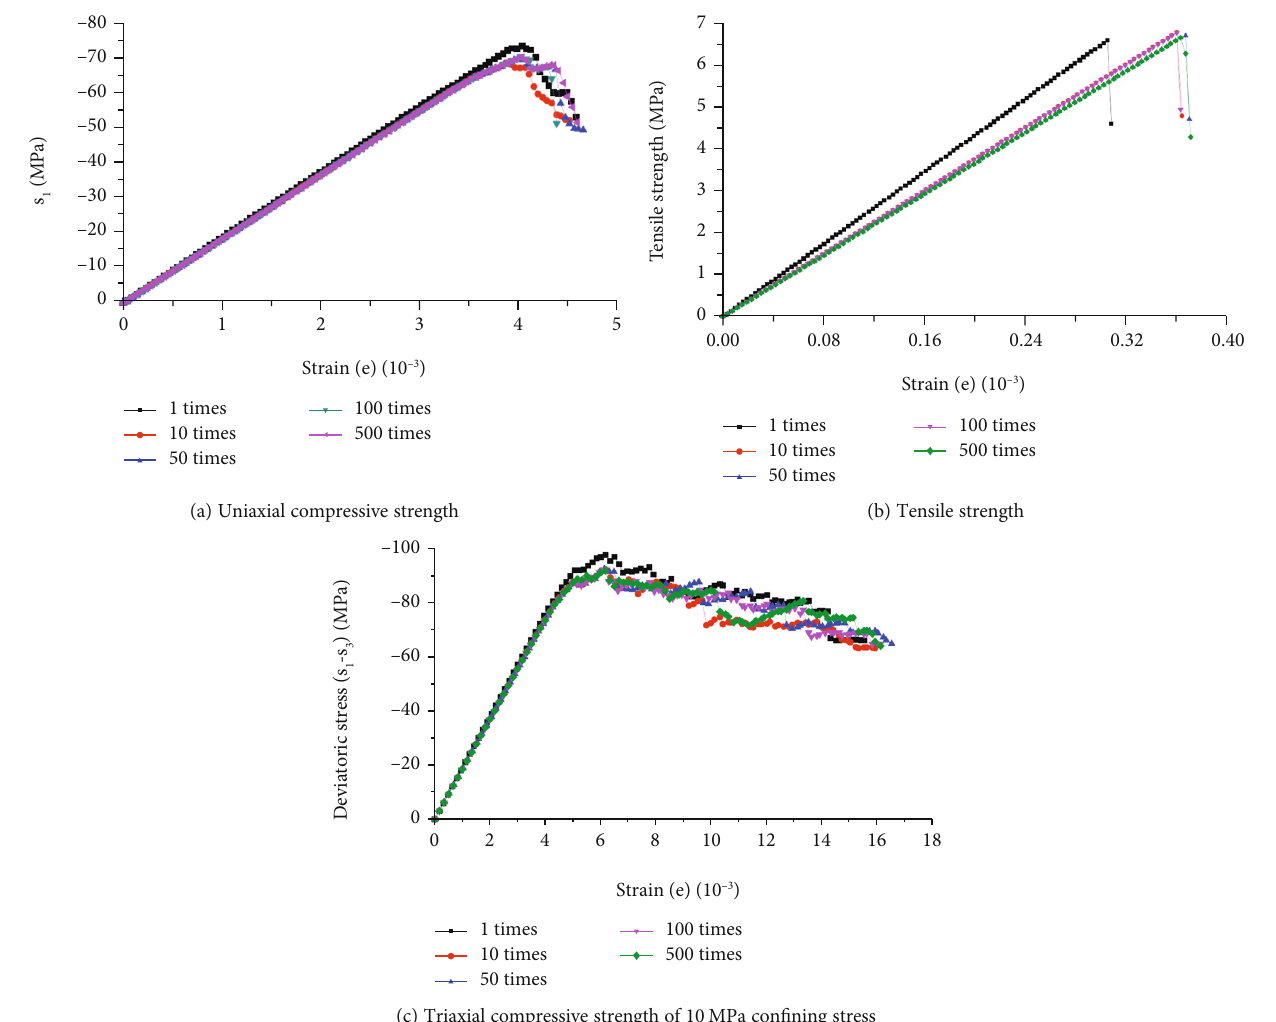
Figure 5: Strength contrast of blocks with di ff erent size particles. After coal seam mining, the fracture of bedrock was shown in Figure 8, and the subsidence curves of bedrock were shown in Figure 9. In Figure 8, it can be seen that the fracture propaga- tion angle at the open-o ff cut side was 63.6 ° , that at the stop line side was 61.1 ° , and the corresponding values obtained by physical test were 65.2 ° and 61.4 ° , respectively. It can be seen that the fracture morphology of strata in numerical sim- ulation and physical simulation is almost consistent. The comparison of the model top subsidence curve between numerical simulation and similar simulation was shown in Figure 10. In a similar simulation, the average subsidence value in the subsidence basin was 3.259 m, and that value was 2.770 m in numerical simulation. There was a di ff erence of 0.489 m between these two results. Compared with the results of similar simulation, the numerical simulation results were reduced by about 15%. Considering the large size of numerical and physical models, the di ff erence was within Figure 6: Numerical model on bedrock the allowable range. Thus, the numerical model, including parameters selection and external force application, was rea- sonable and could be used in the following analysis.